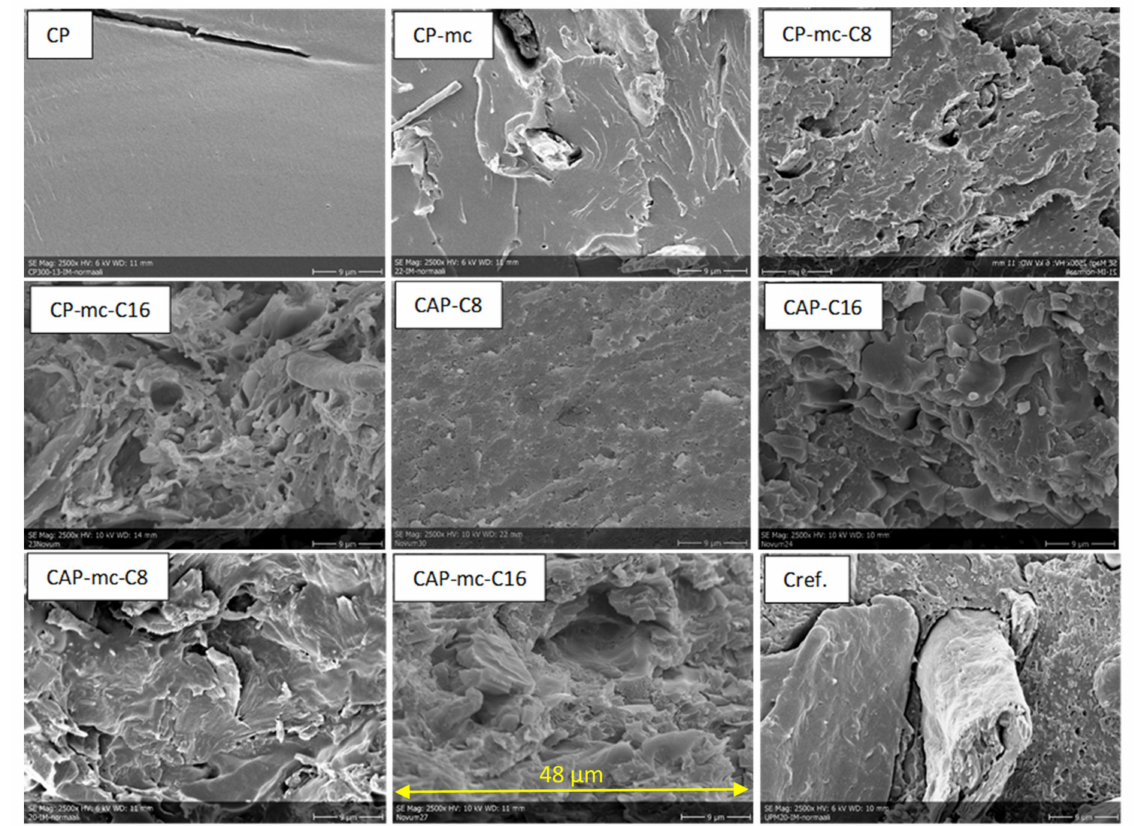
Figure 4. SEM-pictures with 2500 × enlargement from cross-cut middle of the injection molded test bars. The width of each pictures is 48 µ m. CP is commercial cellulose acetate propionate with 13% commercial plasticizer; CP-mc is 20% microcellulose containing CP; CP-mc-C8 contains also 4% cellulose octanoate C8; CP-mc-C16 contains 4% of cellulose palmitate C16; CAP-C8 contains neat cellulose acetate propionate (CAP) with 17% C8; CAP-C16 contain 17% C16 in CAP; CAP-mc-C8 contains 20% mc and 17% C8 in CAP; CAP-mc-C16 contains 20% mc and 17% C16 in CAP and Cref is PLA-based material with 20% cellulose